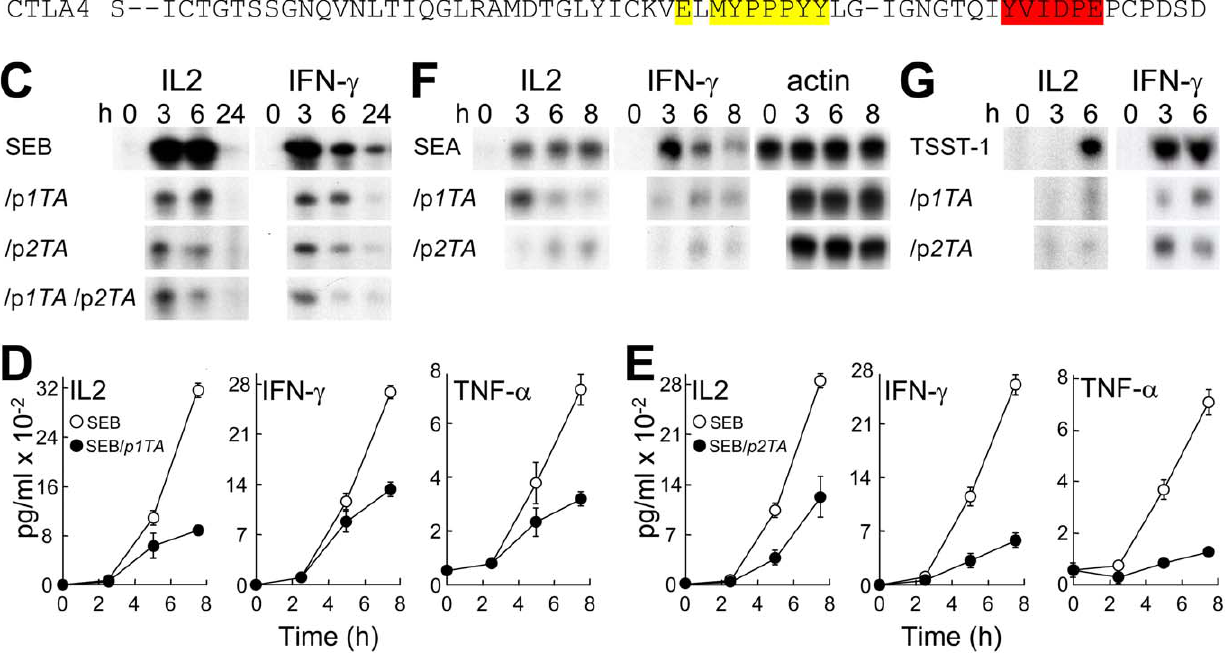
Figure 4. Peptide mimetics of the CD28 dimer interface are superantigen antagonists. (A) CTLA-4/B7-2 complex (1I85.pdb; [1]) and the dimer interface in CTLA-4. B7-2 is shown in purple and CTLA-4 in blue, with MYPPPY in yellow, YVIDPE (HVKGKH in CD28) in red, and VVLASS (MLVAYD in CD28) in green, as in the sequence alignment of the extracellular domains of human CD28 and CTLA-4. Amino acids at the crystallographic dimer interface of CD28 [21] are shown in blue. Positions of peptides are underlined. (B) p 1TA antagonizes induction of IFN- c mRNA by a CD28. PBMC were induced by a CD28 (2.5 m g/ml) alone or with 10 m g/ml of CD28-Fc or p 1TA . IFN- c and b -actin mRNA was determined. (C–E) CD28 dimer interface peptides p 1TA and p 2TA (0.1 m g/ml) inhibit induction by SEB of IL2 and IFN- c mRNA (C) and IL2, IFN- c , and TNF- a (D and E) in PBMC (data are shown as means 6 SEM ( n =3 experiments)). (F and G) Induction of IL2 and IFN- c mRNA by SEA (F) and TSST-1 (G) alone or with 0.1 (F) or 10 m g/ml peptide (G); b -actin mRNA indicates equal loading of RNA.